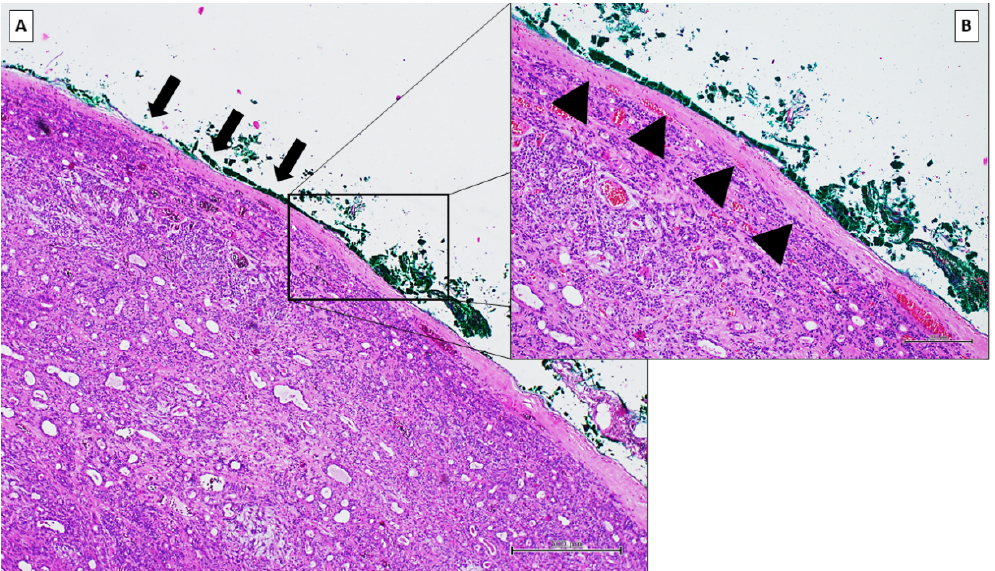
Figure 3. Representative histological examination of ECD of pleomorphic adenoma. ( A ) pleomorphic adenoma with the excision margin marked with ink (black arrow) (H&E stain, 10× magnification, scale-bar 500 µm). ( B ) detail of the ECD with the integrity of the capsule of the neoplasm histologically observed (black arrowhead) (H&E stain, 20× magnification, scale-bar 200 µm).